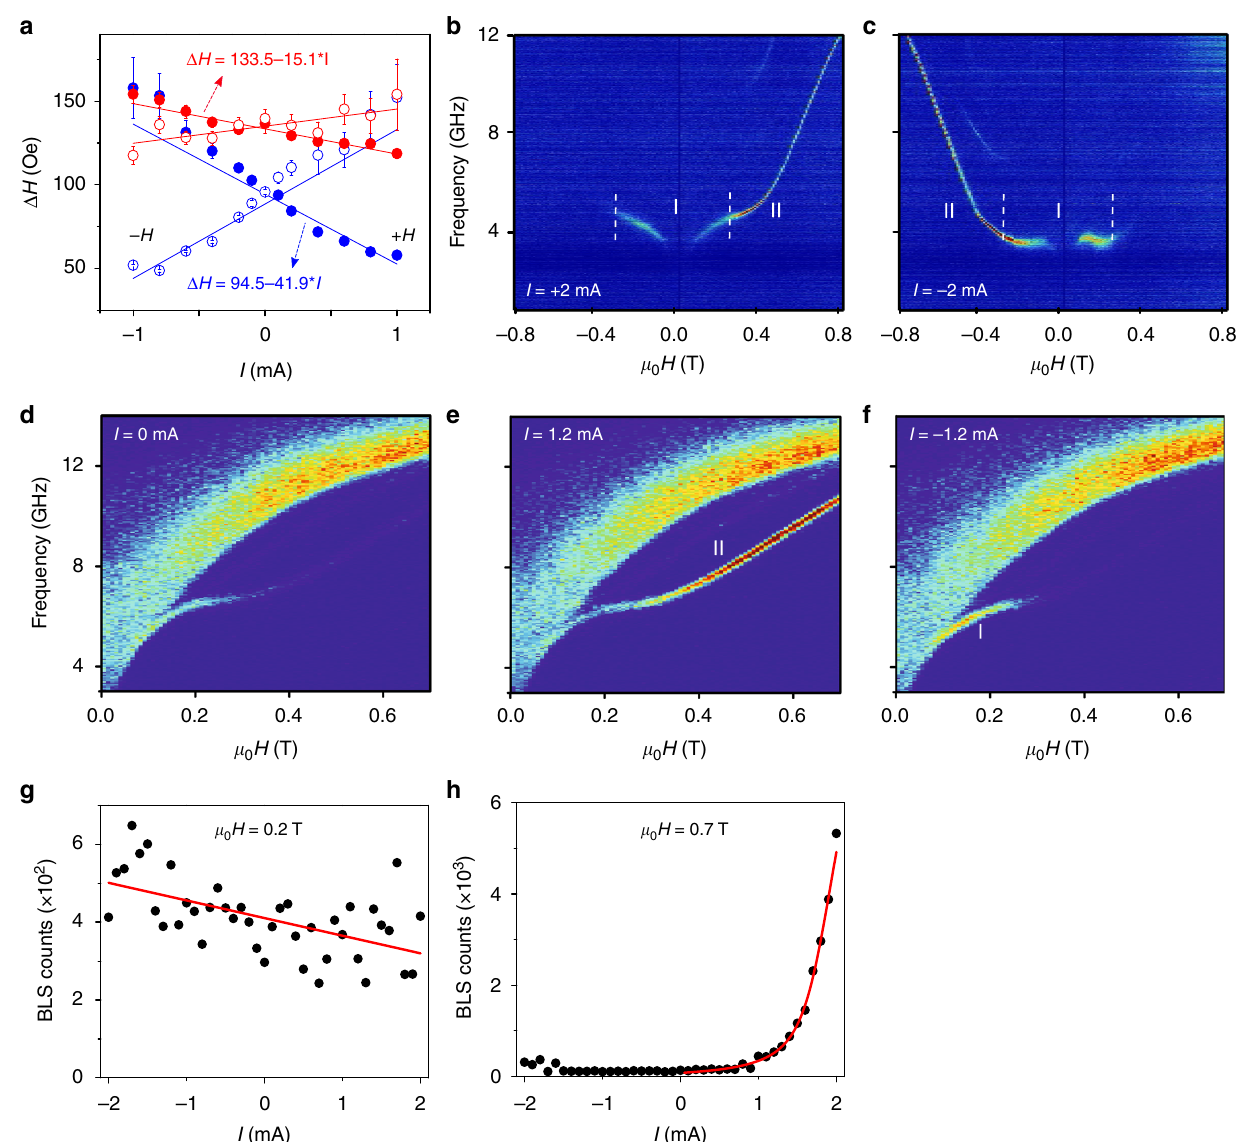
Fig. 2 Current-induced spin wave auto-oscillations. a Current dependent ST-FMR linewidth of the FMR (red circles) and localized (blue circles) modes for positive fi eld ( fi lled symbols) and negative fi eld (open symbols). The error bars are calculated using the standard error of Δ H while fi tting the ST-FMR signals to a function consists of symmetric and anti-symmetric Lorentzian function. b , c Electrical measurements of the power spectral densities of spin wave auto-oscillations vs. applied fi eld measured under a direct current of ( b ) + 2 mA and ( c ) − 2 mA. Label I and II indicate low- fi eld and high- fi eld auto- oscillations, respectively. d – f , μ -BLS measurements of the frequency vs. applied fi eld showing the intensity of the FMR and the localized mode measured at 0 mA ( d ), + 1.2 mA ( e ), and − 1.2 mA ( f ). g , h , show the change of the BLS counts as a function of current at μ 0 H = 0.2 T and μ 0 H = 0.7 T. Solid red lines in g , h , are a linear fi tting, and fi tting to the theoretical prediction of Eq. (84a) in ref. 29 ,